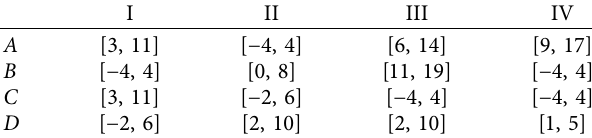
Table 4: Subtraction of the minimum interval in each column.